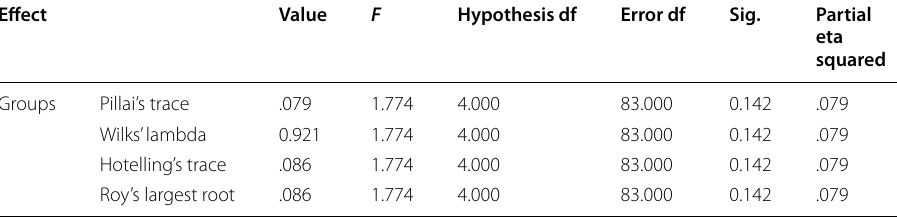
Table 2 MANOVA results comparing EG and CG on RCA pretest, AM pretest, FLA pretest, and SS-E pretest